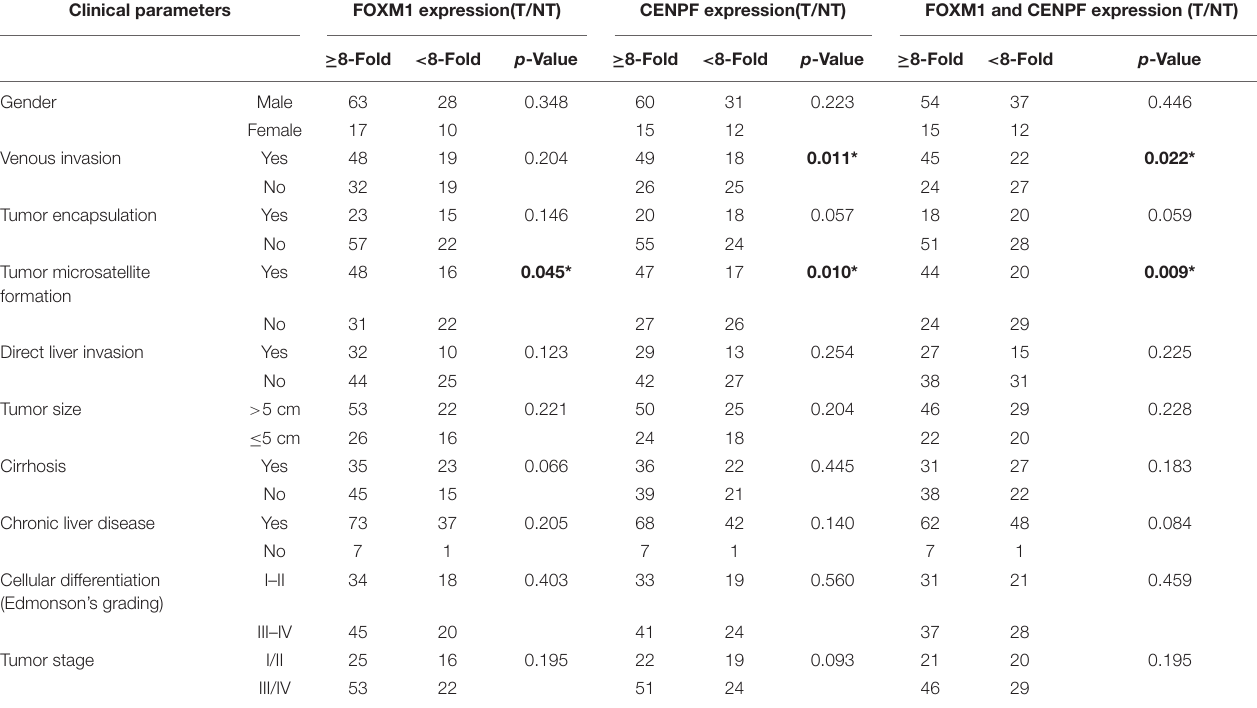
TABLE 1 | Clinicopathological correlation analysis of FOXM1 and CENPF. Clinical parameters